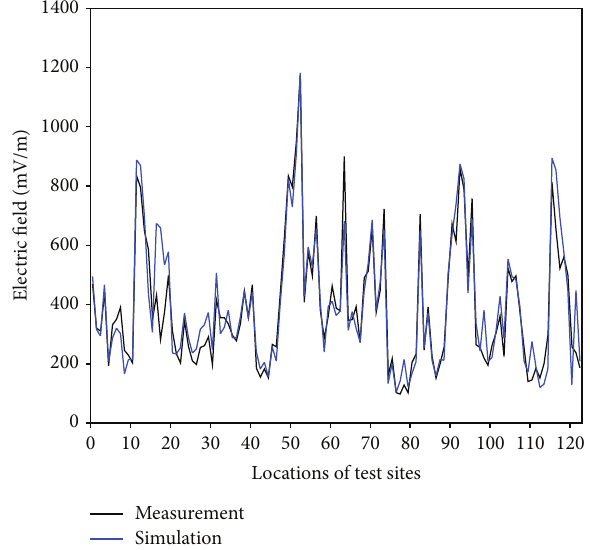
Figure 10: Comparison of simulated and measured electric field distributions. Simulated results are carried out for the LTE base station antenna with a down-tilting angle of 8 degrees and measured data is performed for the LTE base station antenna with a down- tilting angle of 8